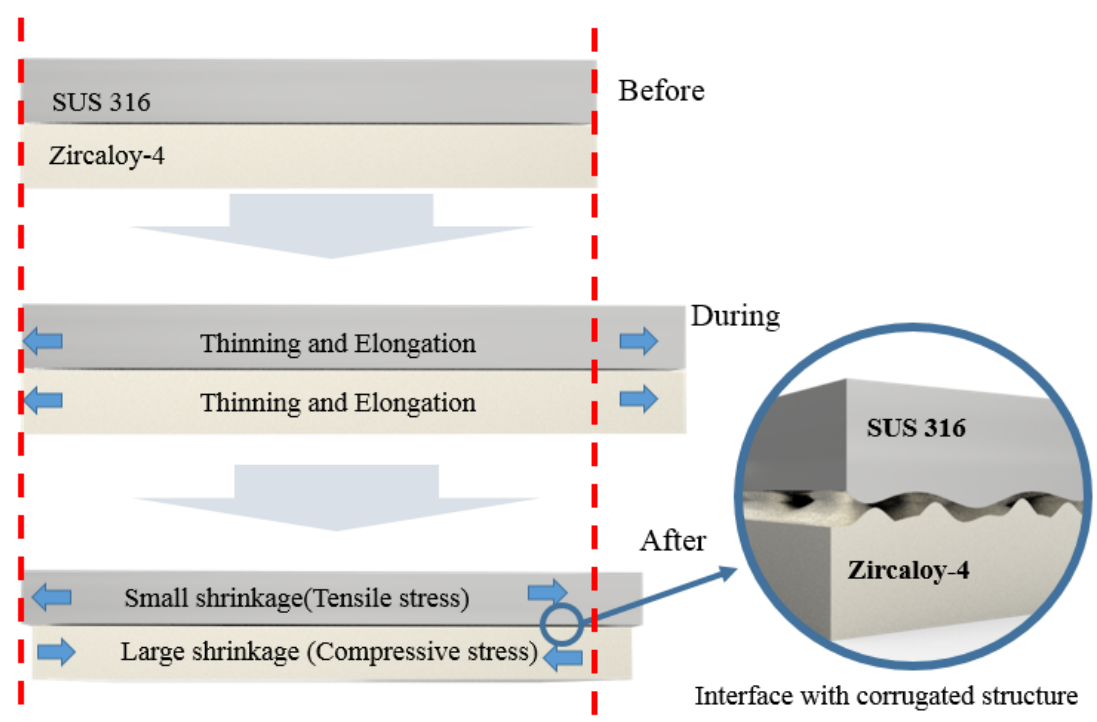
Figure 7. Mechanism for strong physical adhesion of different tubes due to residual stresses generated by the shaft tube process.